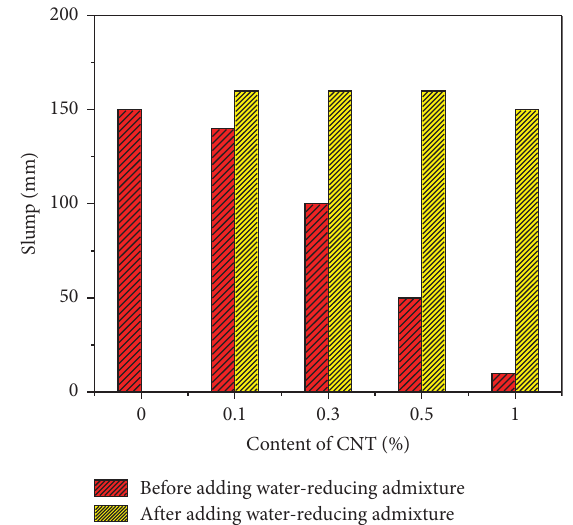
Figure 6: Slump of fresh concrete with different amounts of CNTs